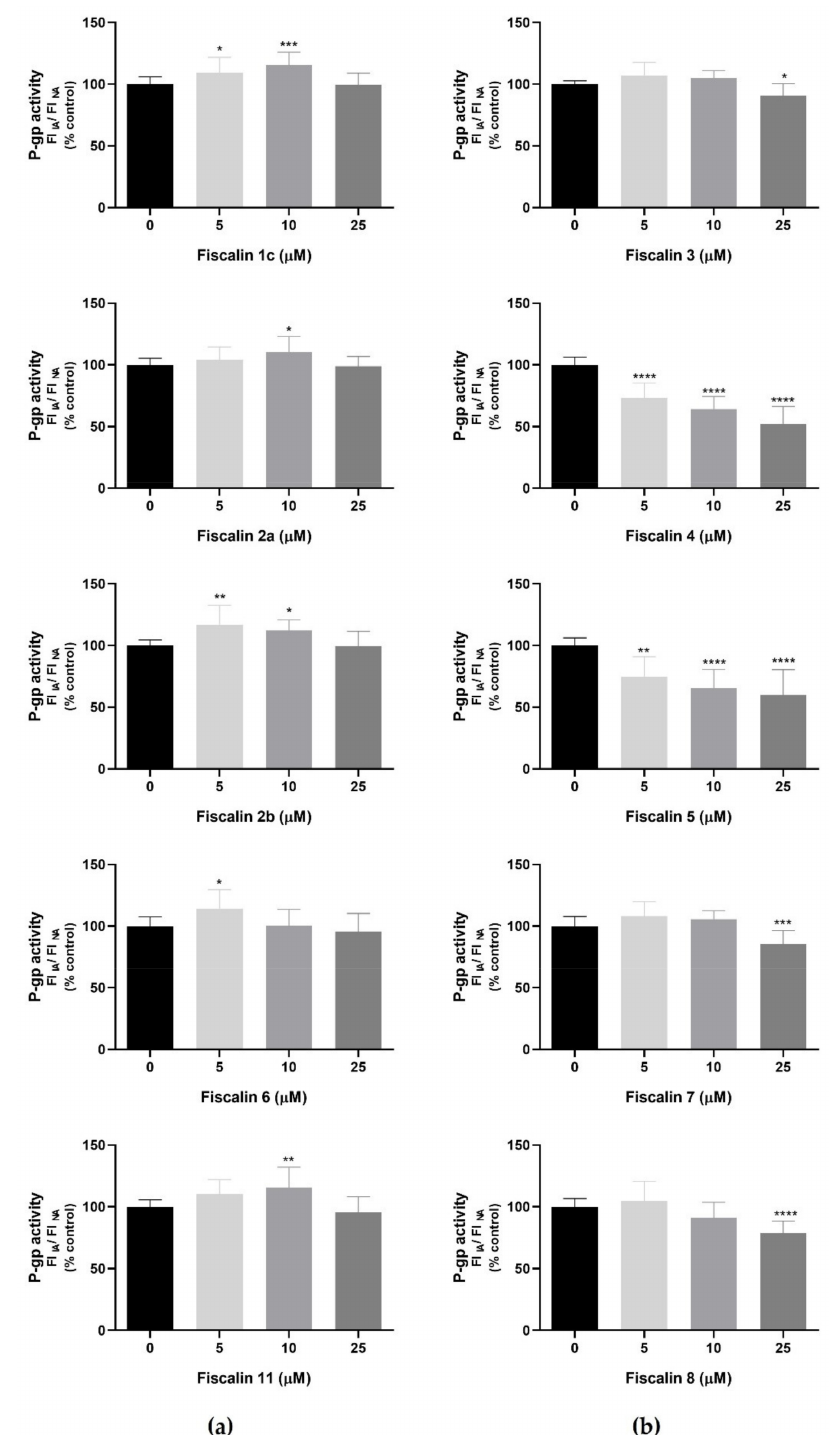
Figure 3. Evaluation of the fiscalins (0–25 µ M) potential for P-glycoprotein activation ( a ) and in- hibition ( b ). P-glycoprotein activity was evaluated by fluorescence spectroscopy in differentiated SH-SY5Y cells exposed to the tested fiscalins (0–25 µ M) during the 90 min incubation period with the fluorescent substrate (10 µ M RHO 123). Results are presented as mean ± SD from four indepen- dent experiments, performed in triplicate. Statistical comparisons were made using the parametric method of one-way ANOVA, followed by Dunnett’s multiple comparisons test [* p < 0.05; ** p < 0.01; *** p < 0.001; **** p < 0.0001 vs. control (0 µ